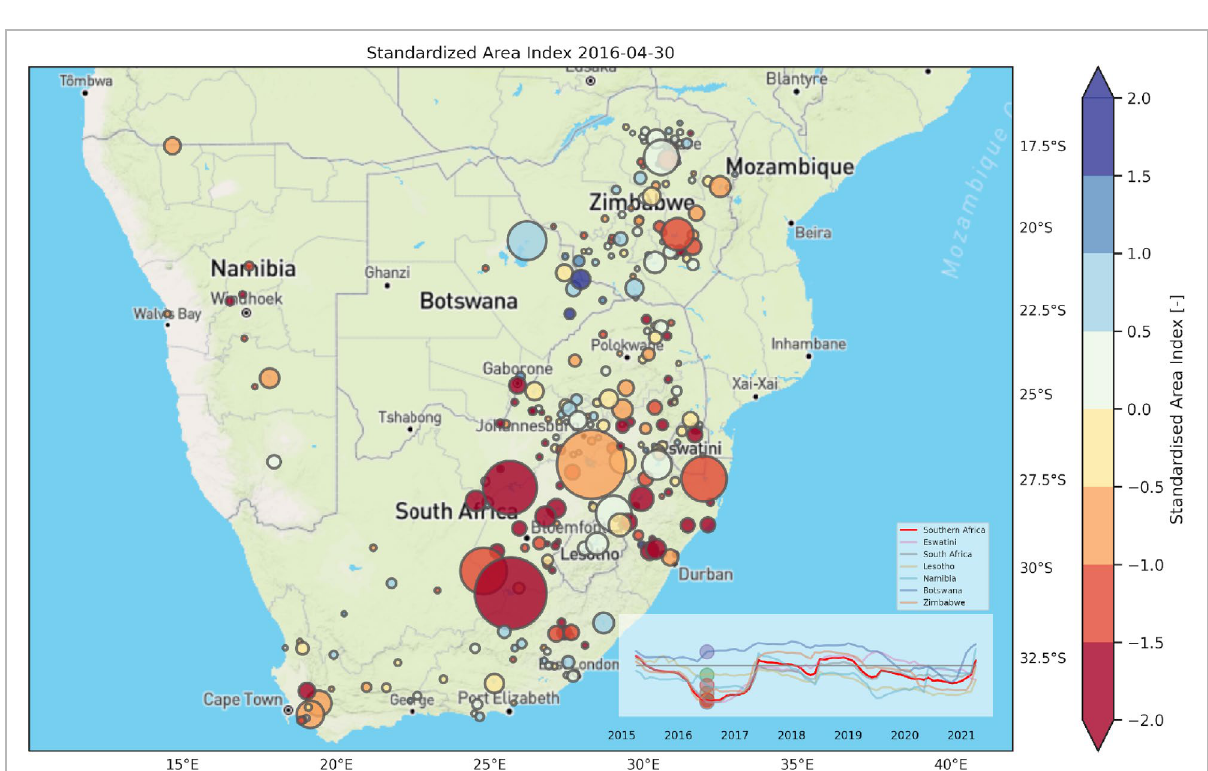
Figure 4. Standardized Area Index for all reservoirs > 1 km 2 in South Africa, Eswatini, Lesotho, Namibia, Botswana, and Zimbabwe in April 2016. The size of the circles represents the mean surface water area of the reservoirs during 1985–2021. The colors of the time series (lines), and the plotted moment in time (circles) in the inset plot, correspond with the country in the legend. The figure is generated using Matplotlib 34 and Cartopy 35 python